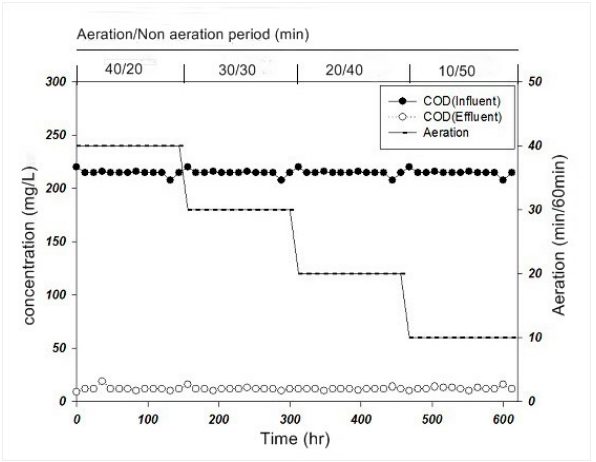
Figure 7. COD concentration in MBR with intermittent aeration.